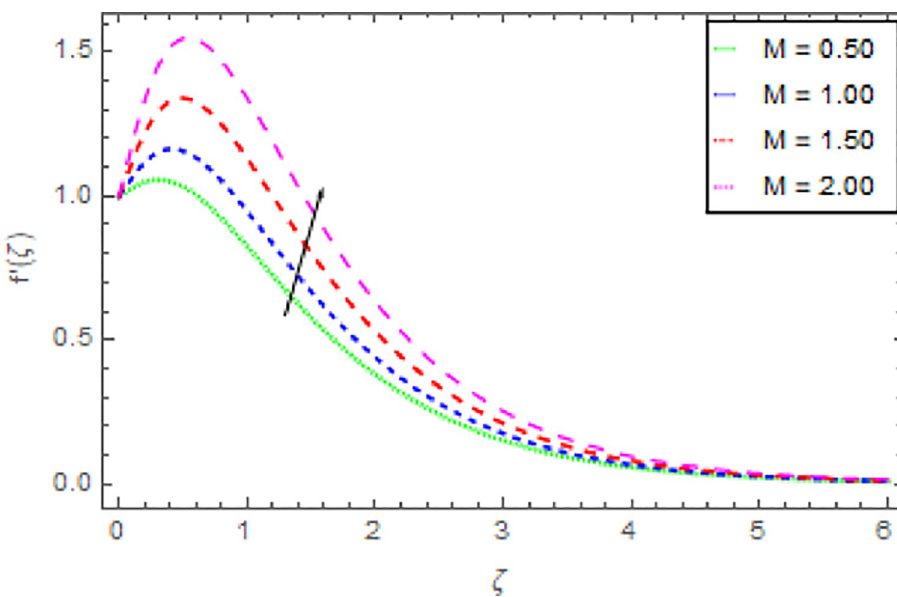
Fig 2. Deviation in nanofluid velocity ( x − direction) against M when Pr = 1000, m = 0.10, n = 1.00, δ = 0.40, β = 1.00, Nr = 0.20 and ϕ = 0.01 to ϕ = 0.04.